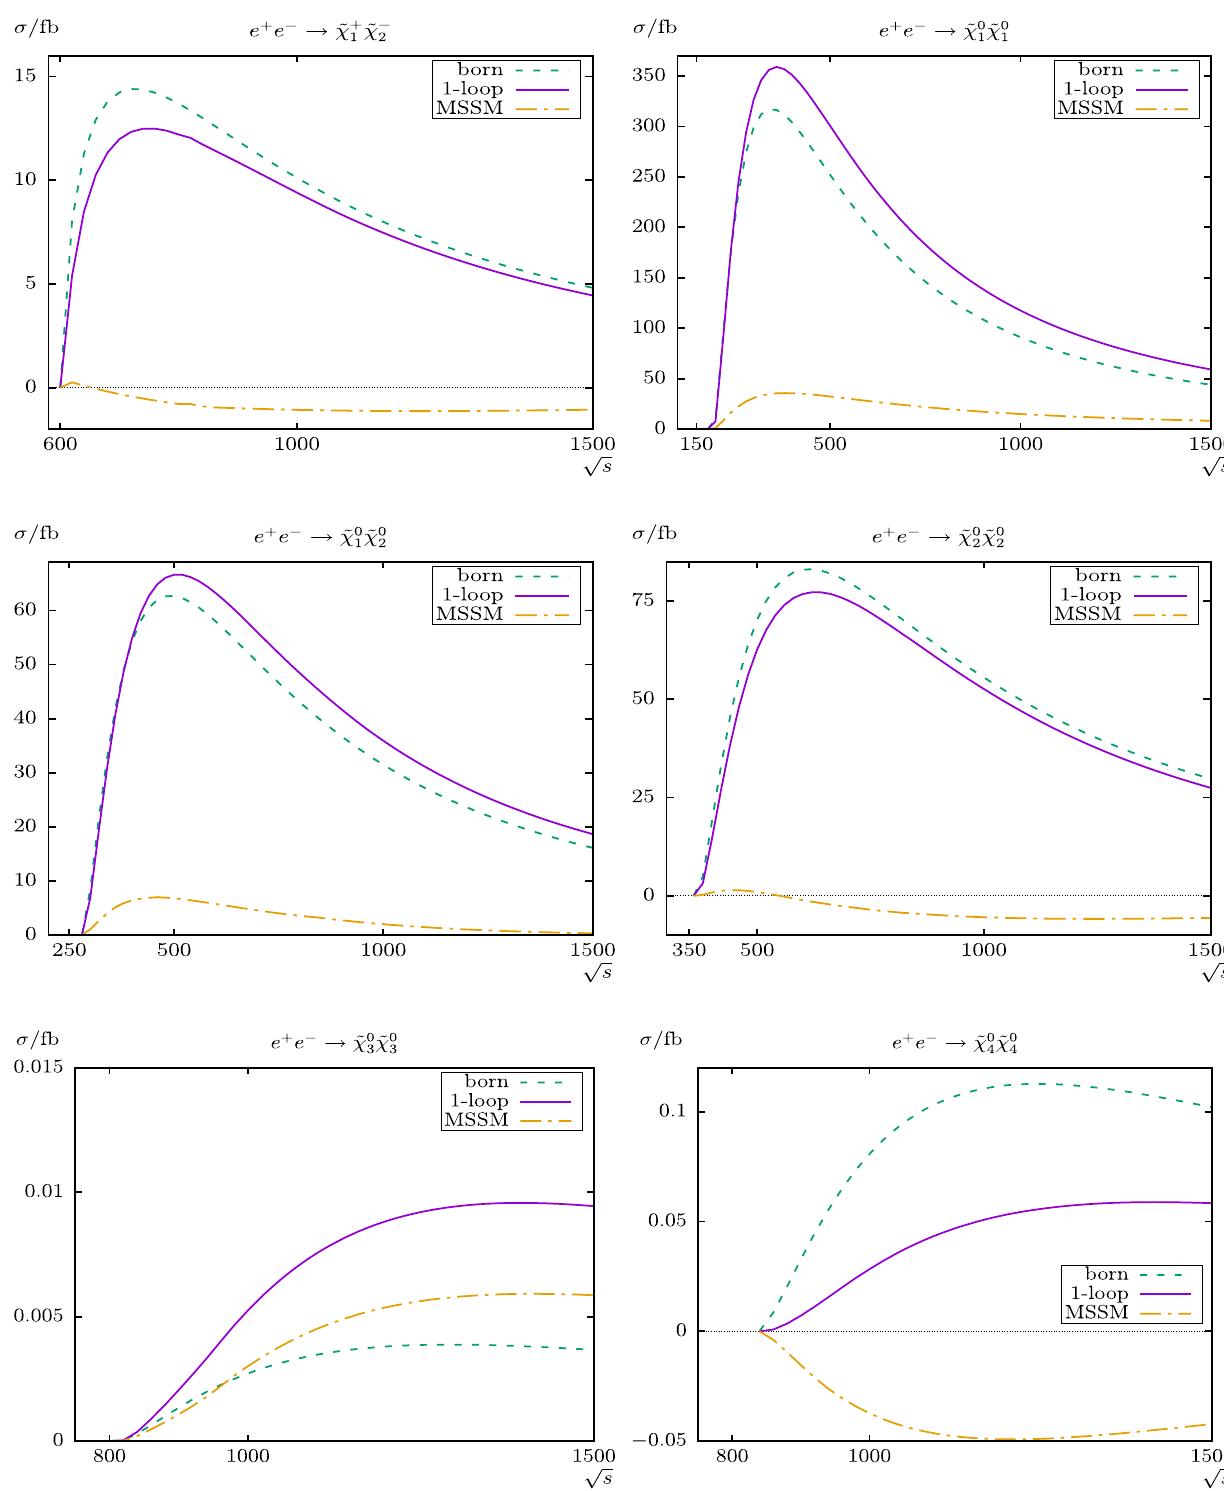
) and σ( e + e − → ˜ χ 0 ˜ χ 0 ) . As example some of the cross sections (in fb) are shown with √ n c (cid:4) n (cid:4) s (in